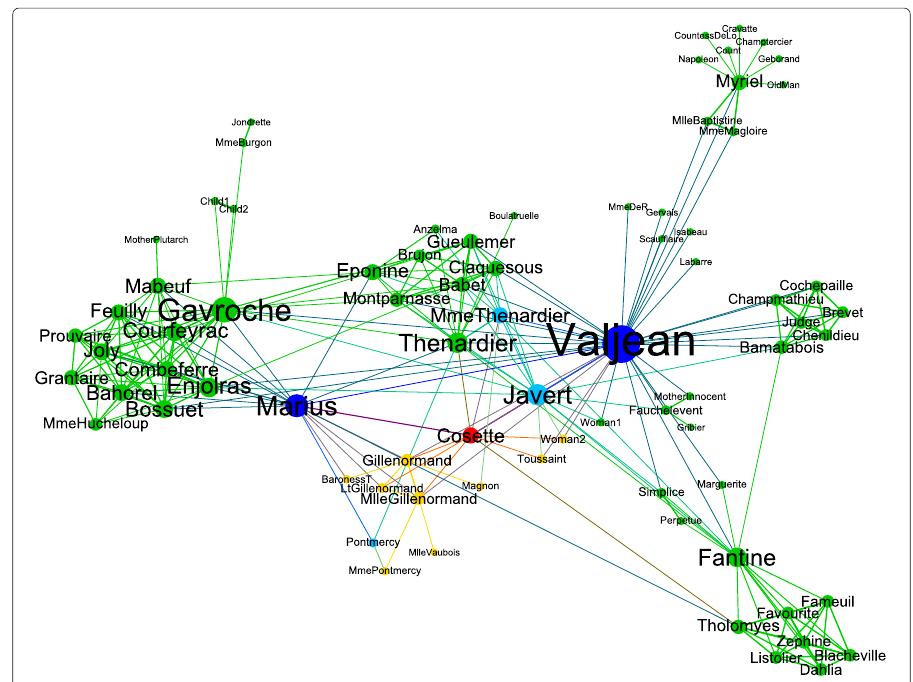
Fig. 5 Cosette’s zone in Les Misérables network. The zone in which the red node Cosette is ego; the yellow nodes belong to inner-zone and the blue nodes to outer-zone; dark blue nodes play liaison role and light blue nodes co-liaison role. Green nodes are outside the